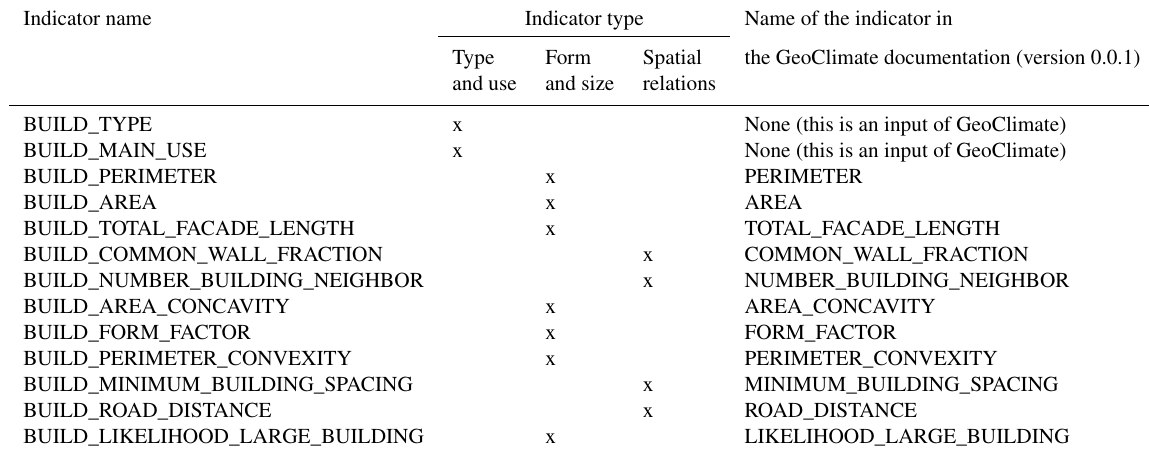
Table A1. List of all building scale spatial indicators used as inde- pendent variables.